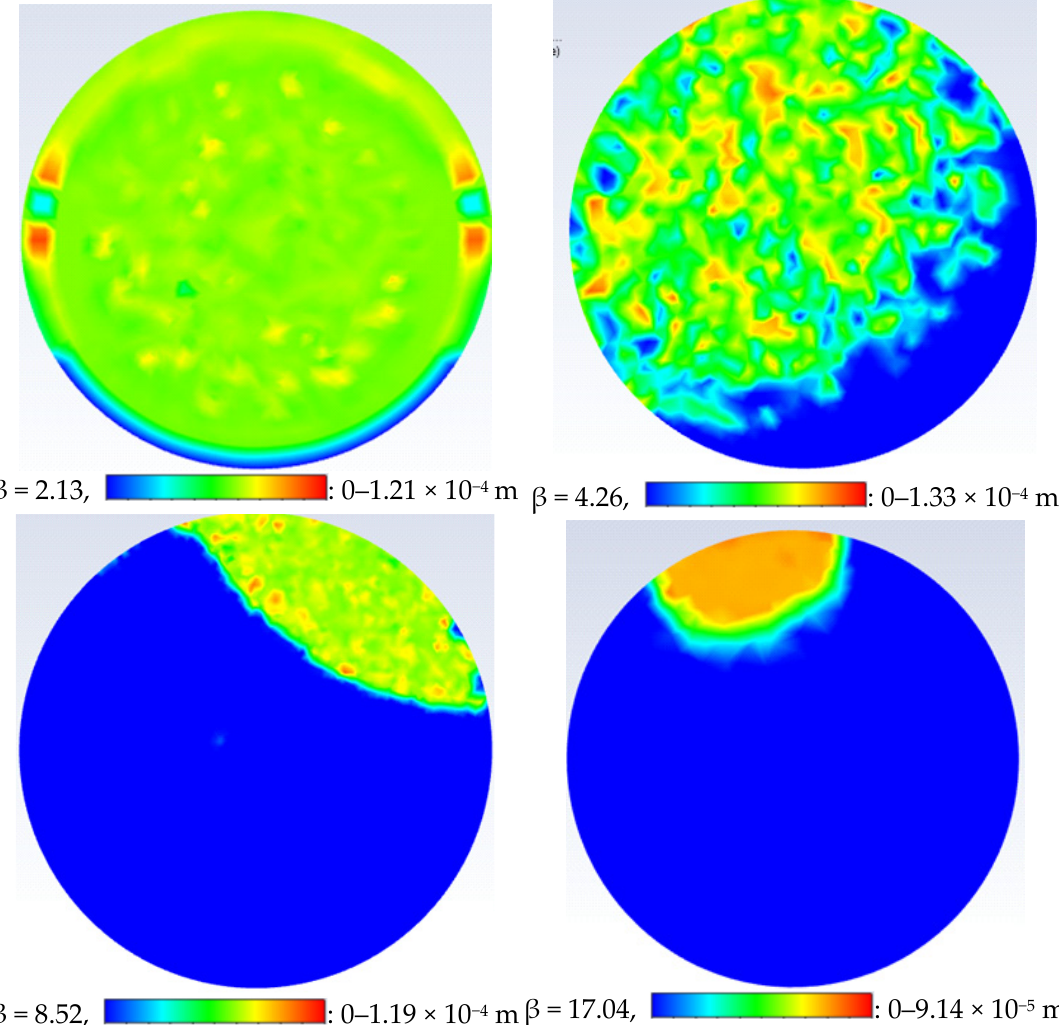
Figure 16. The contours of bubble distribution at the outlet section of the diffuser. (Water flow rate = 8.21 L/min, air flow rate = 0.1 L/min).